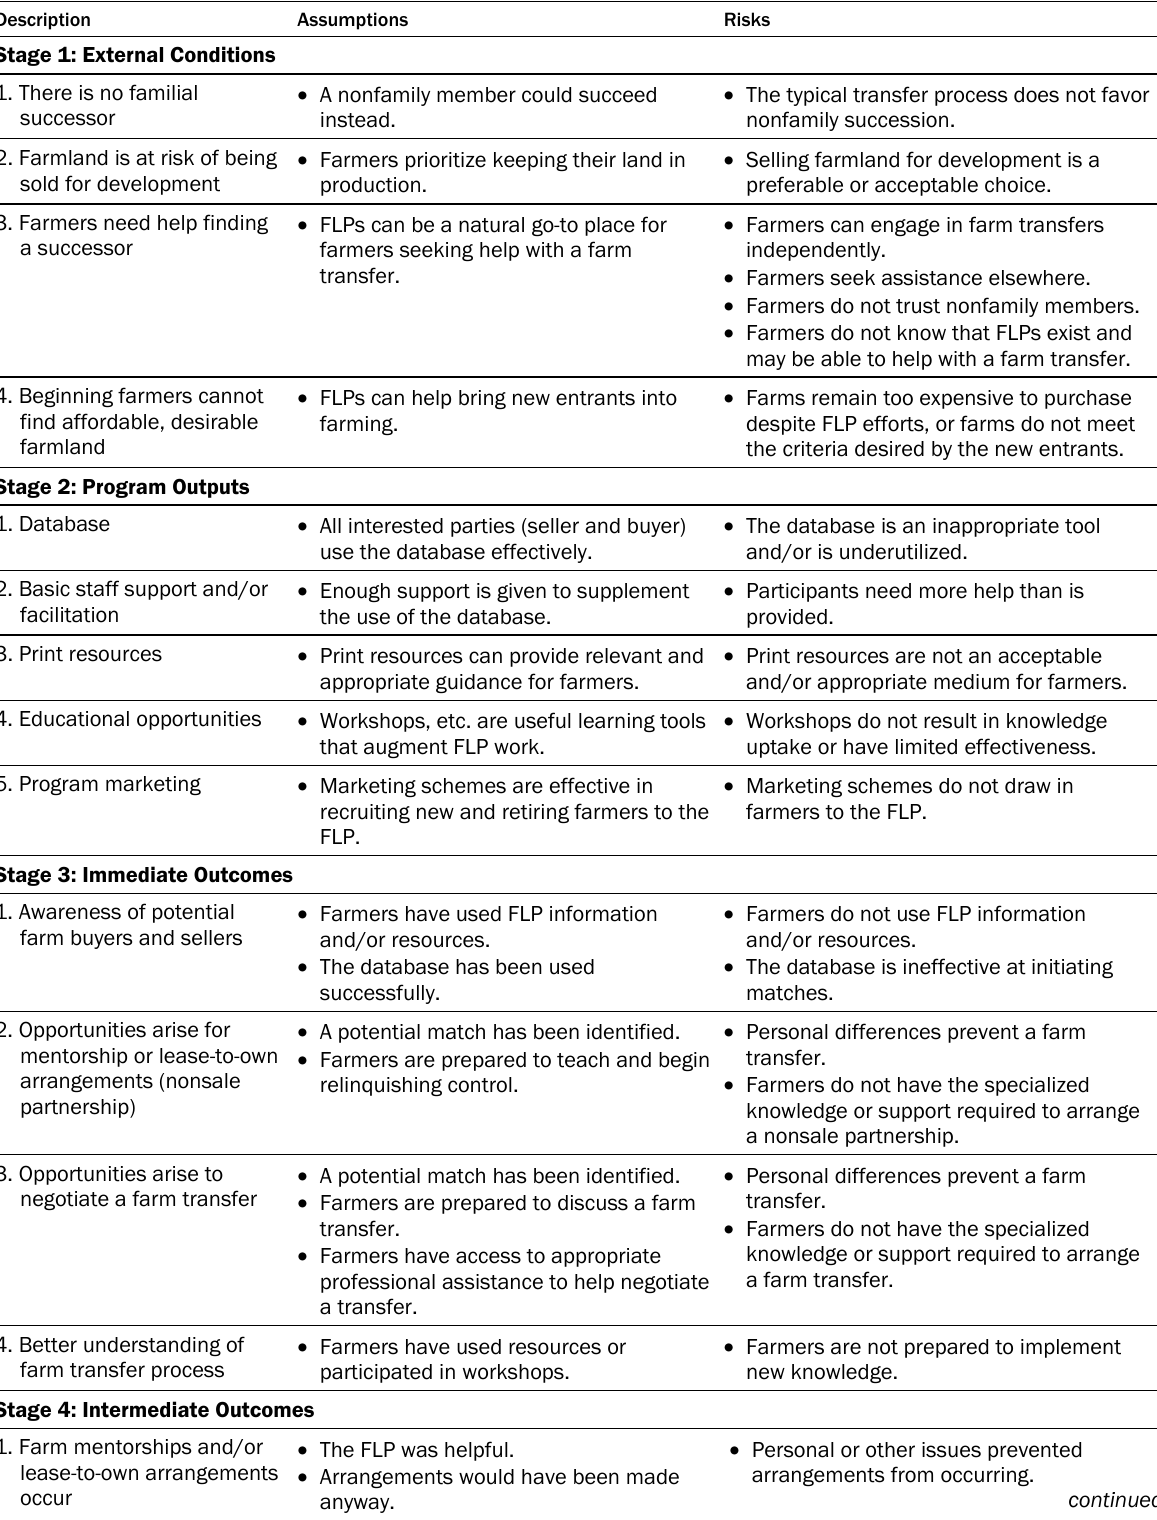
Table 2. Theory of Change for a Farm Link